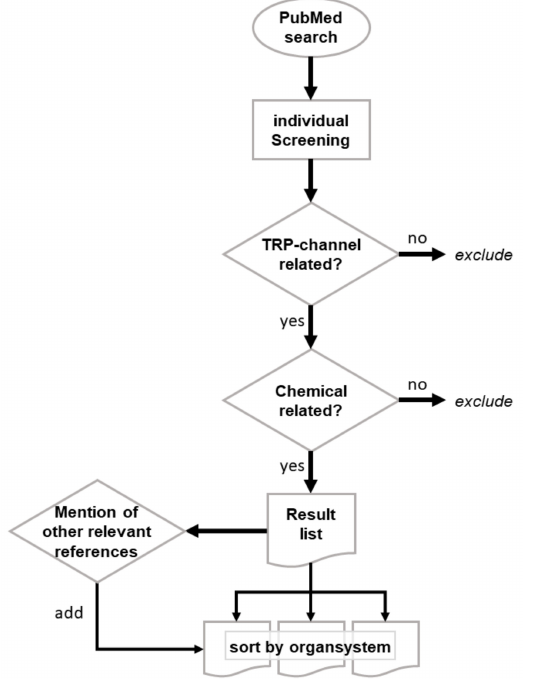
Figure 1. Search algorithm for the identification of relevant literature. The PubMed database was searched using “(trp channel) AND (toxic * OR chemical)” as a search term. The resulting 579 hits were screened. Literature not related to the topic of this review was excluded. If selected literature pointed to other references that were initially not identified in the PubMed search, these were also screened and